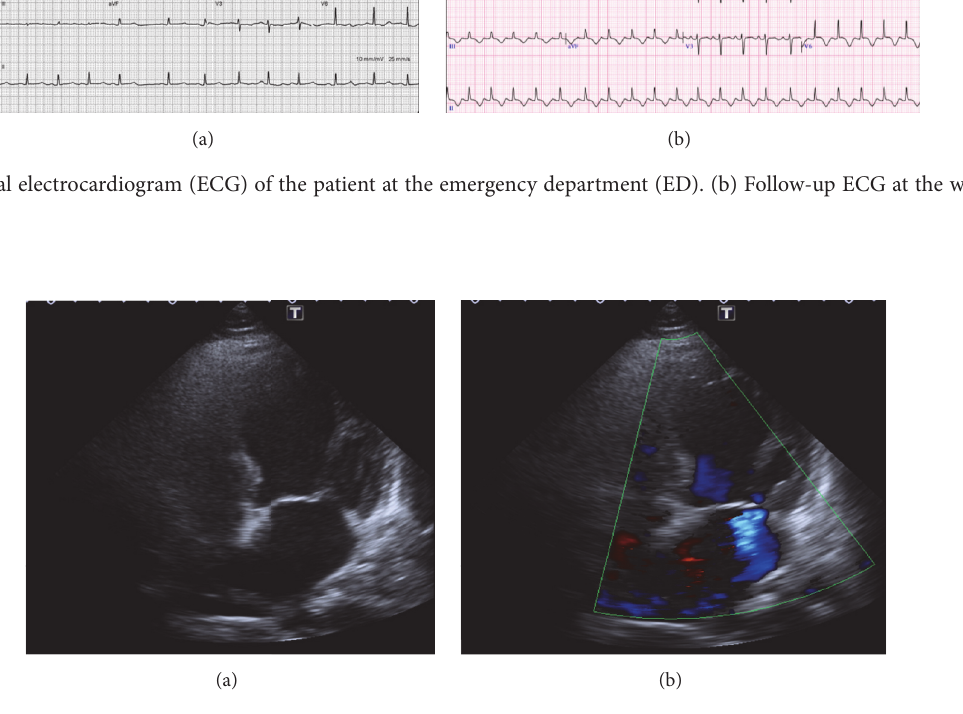
platelet count 163000/ 𝜇 L, glutamic pyruvic transaminase (GPT) 22 IU/L, creatinine 1.0 mg/dL, troponin I 0.06